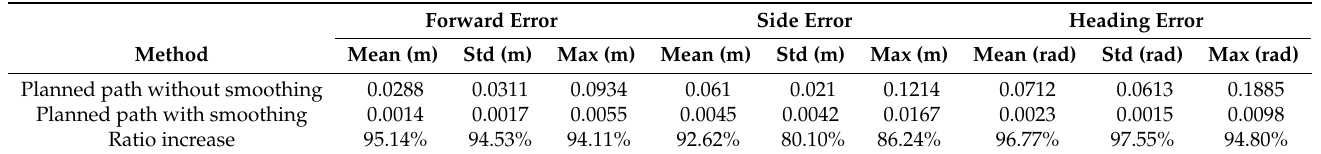
Table 1. Forward and side translation and orientation errors.